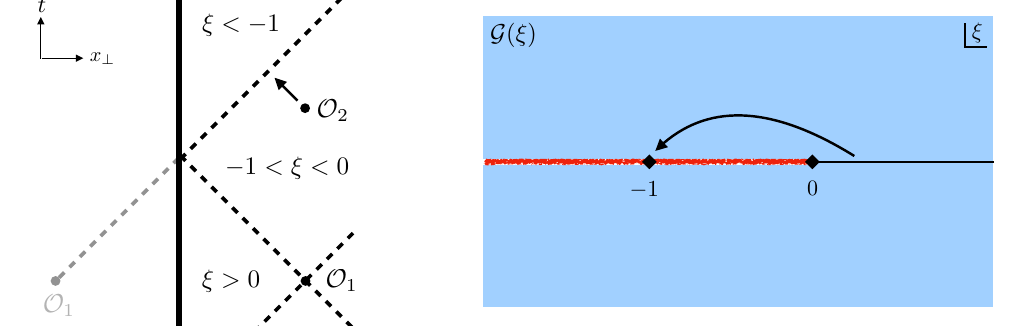
Figure 1. Left: the Regge limit of a two-point function in the presence of a conformal boundary condition. The thick vertical line represents the (timelike) boundary. In the Regge limit, approaches the lightcone of the mirror re(cid:13)ection of start with ( (cid:24) ) in the Euclidean regime (cid:24) > 0 and analytically continue to (cid:24) G we need to go around the branch point (cid:24) =